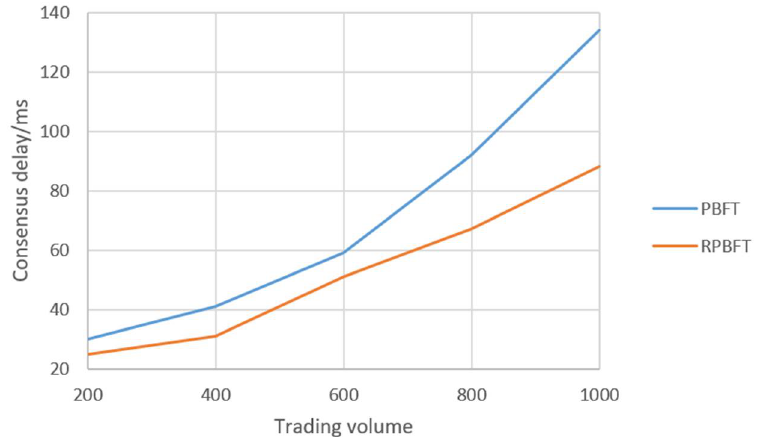
Figure 10. Comparison of consensus delays under different trading volumes.